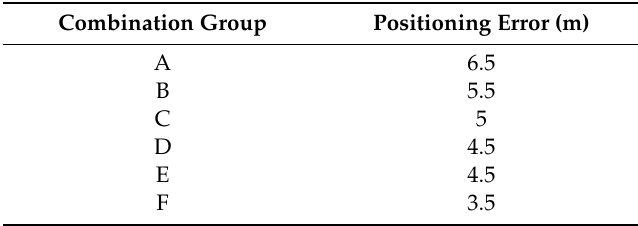
Figure 19. Comparison of the positioning results of different combination groups in experimental environment. Table 5. Positioning errors comparison of different combination groups at the 90% CDF in experimental environment.